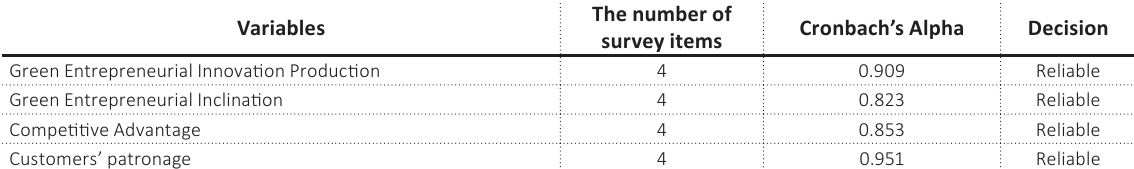
Table 3. Reliability values